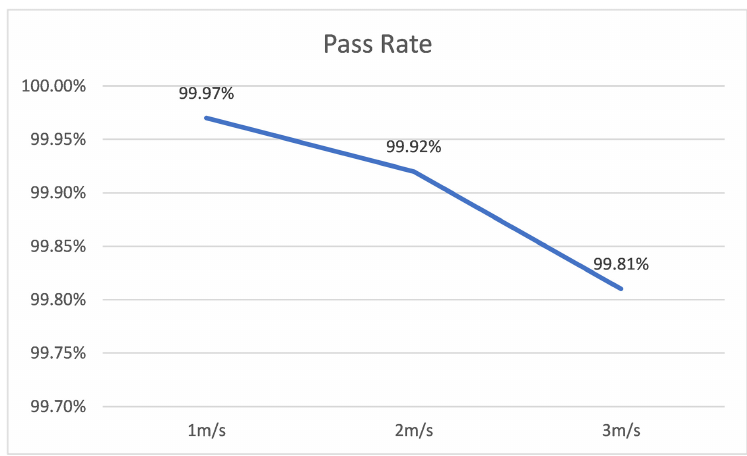
Figure 8. Relationship between Seeding Quality and Positioning Accuracy.